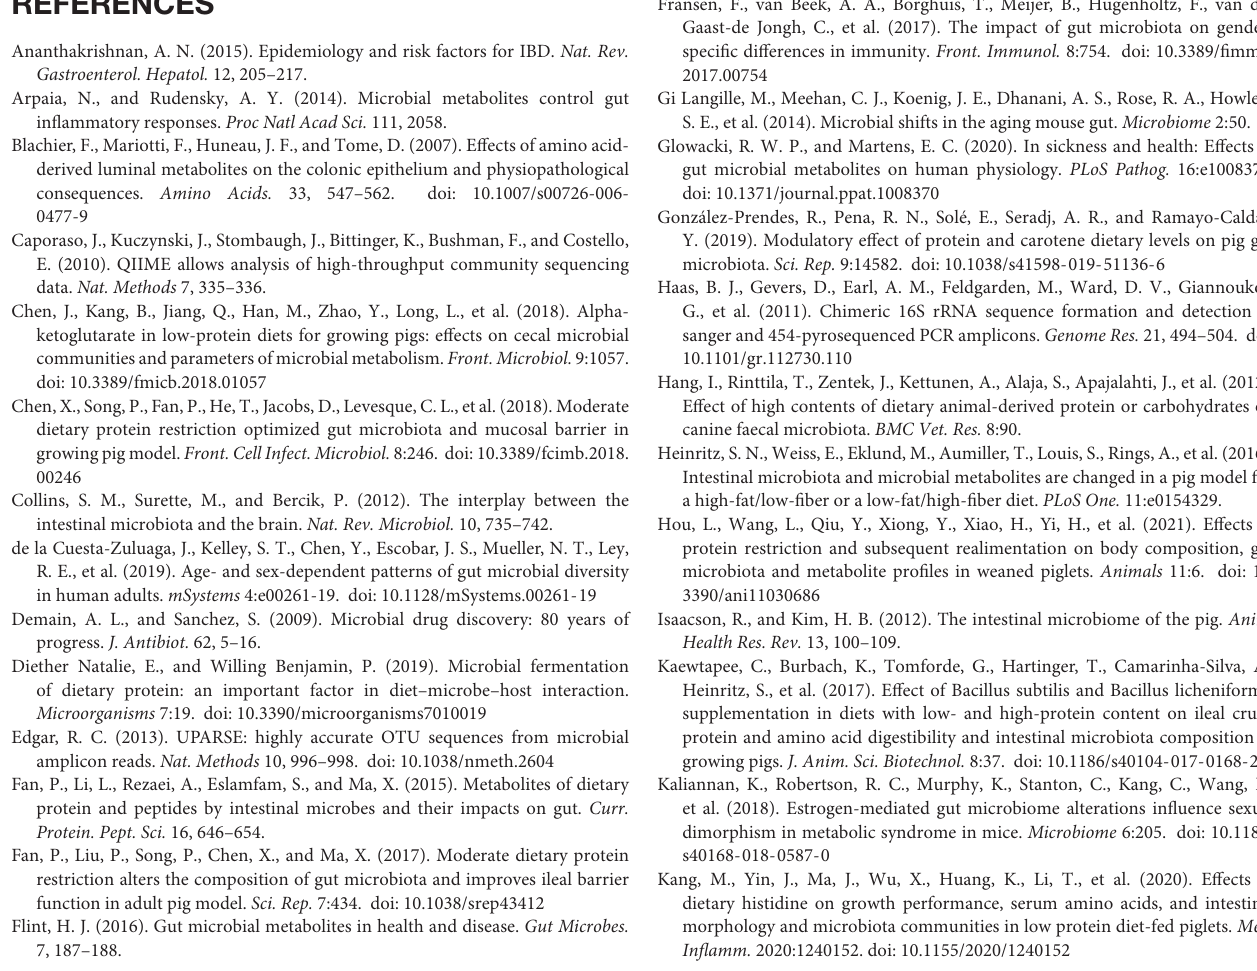
Supplementary Figure 2 | PCA score plot of colonic metabolomic data for barrows and gilts fed low and high protein diets. (A) Effects of dietary protein